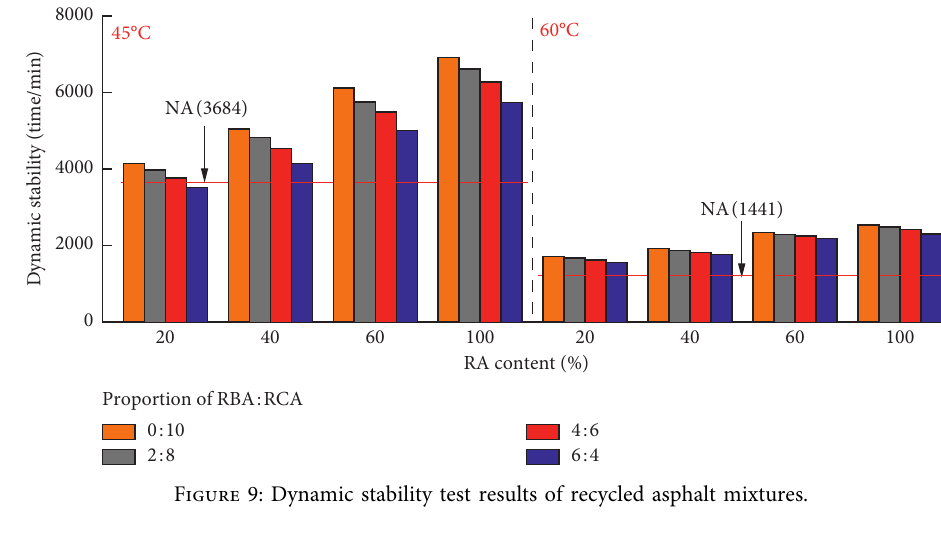
Figure 9: Dynamic stability test results of recycled asphalt mixtures.